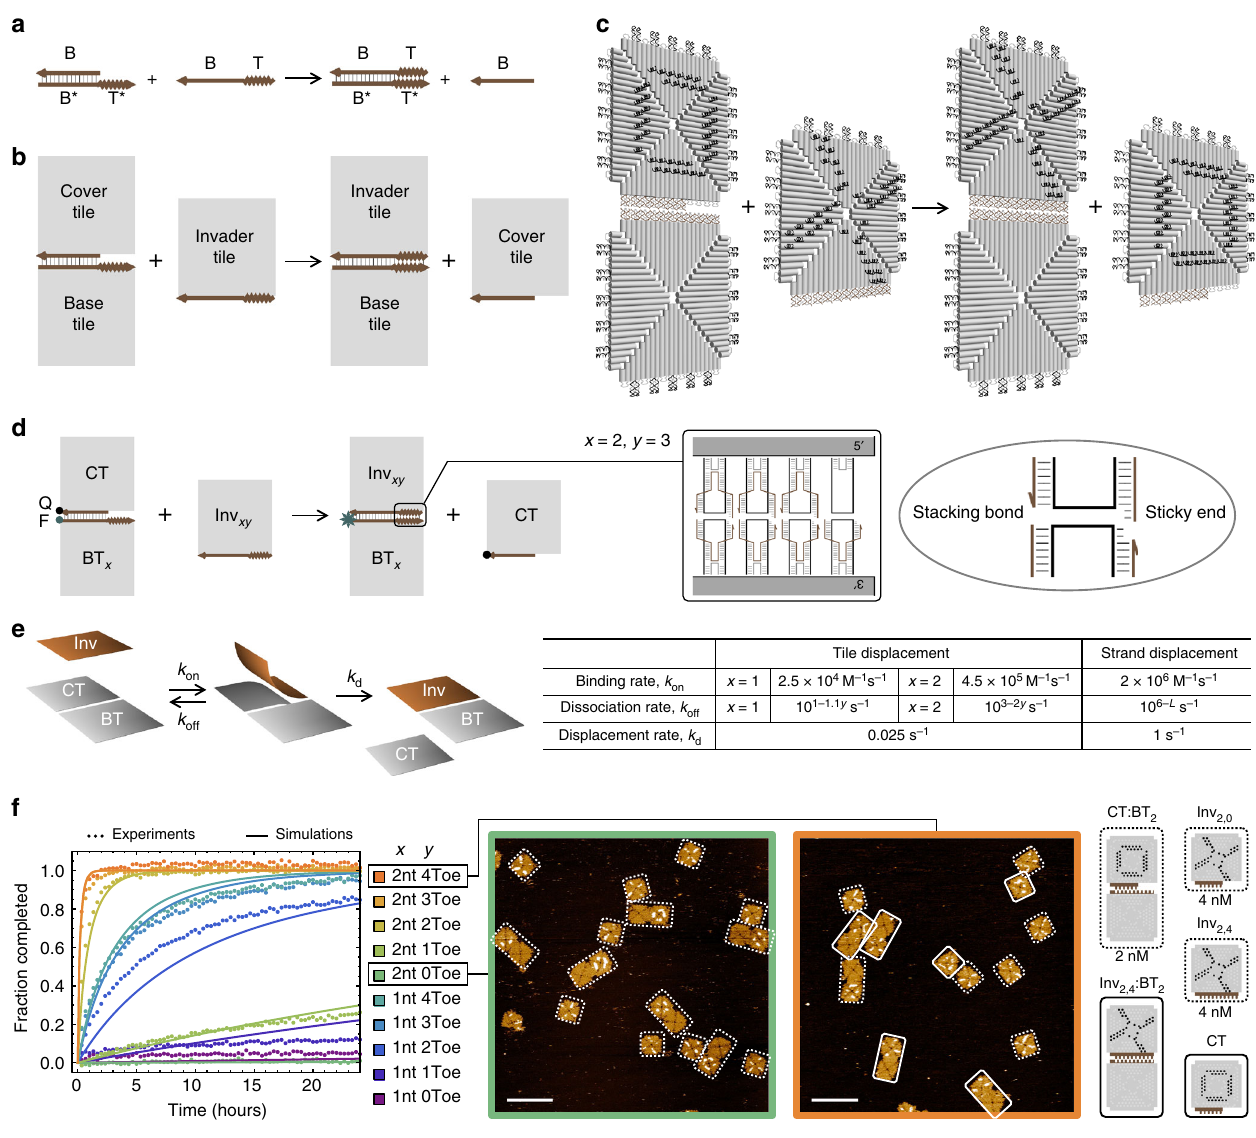
Fig. 1 Concept and kinetics of DNA tile displacement. a Domain-level diagram of a DNA strand displacement reaction. T is a short toehold domain of typically 3 to 8 nucleotides. B is a long branch migration domain of typically 15 to 20 nucleotides. Asterisks in the domain names indicate sequence complementarity. b Domain-level and c origami-level diagram of a DNA tile displacement reaction. Toehold and branch migration domains are composed of 4 and 7 edge staples, respectively. Invader tile and cover tile are labeled with double-stranded staple extensions in an X and O pattern, respectively. d Tile displacement reactions with varying toeholds. CT is a cover tile. BT x is a base tile with x = 1 or 2 indicating the number of nucleotides in the sticky end of each of the 4 edge staples in the toehold domain. Inv xy is an invader tile with y = 0 through 4 indicating the number of edge staples in the toehold domain. F and Q indicate a fl uorophore- and quencher-labeled edge staple, respectively. e Model and rate parameters of tile displacement in comparison with strand displacement. L is the number of nucleotides in the toehold domain of a strand displacement reaction with average DNA sequences. f Fluorescence kinetics experiments, simulations, and AFM images of the tile displacement reactions. Experiments were performed at 25 °C and AFM images were collected after 48 h. Dotted and solid boxes highlight reactants and products, respectively. Colons in the species names indicate multi-tile complexes. Scale bars are 200